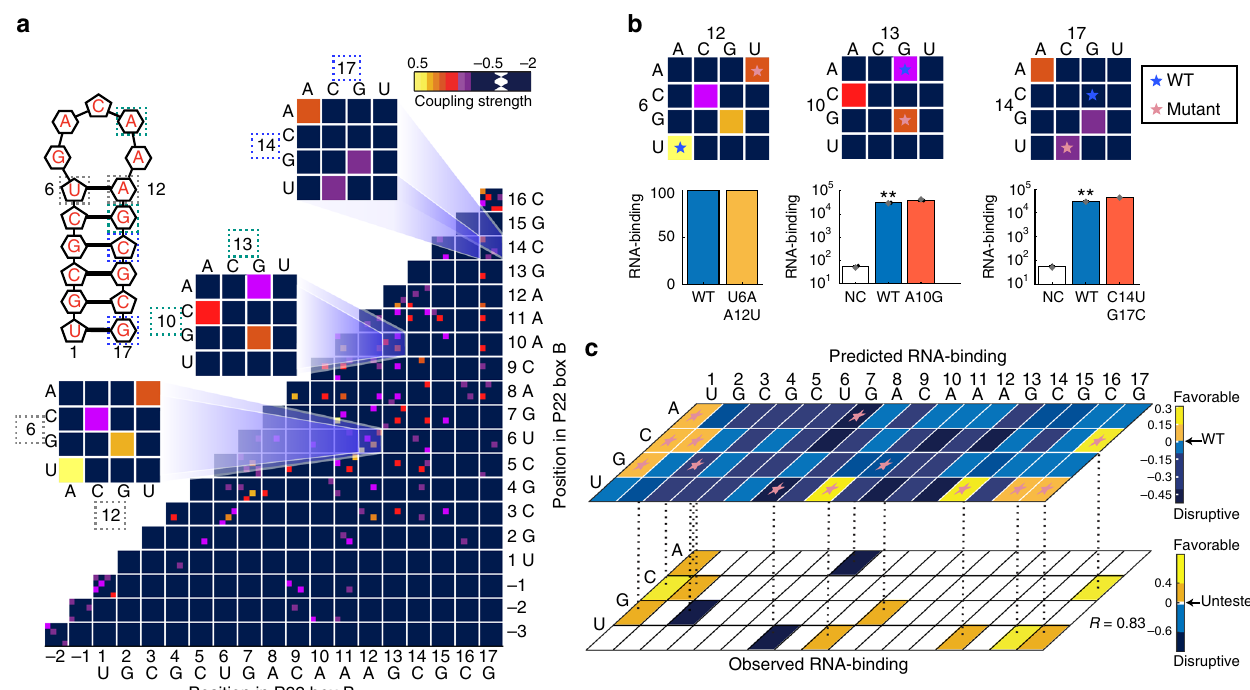
Fig. 3 The P22N DCA-scape elucidates recognition of the Box B left element. a The P22 N protein-binding recognition landscape. Interactions are shaded according to the inset color scale. Representative interactions are enlarged to indicate predicted mutational outcomes. b Experimental con fi rmation of alternative speci fi cities. The wild-type Box B left sequence is indicated with a blue star while mutants are labeled with pink stars. The U6A A12U mutation was previously described as an alternate binding mode and is predicted to result in a favorable interaction (6C – 12C is observed in the wild-type Box B right motif). The A10G single mutant and C14U, G17C double mutant were analyzed using the yeast-three hybrid assay (error bars represent 1 standard deviation, three biological replicates corresponding to separate cultures were conducted for each measurement, **represents p -value < 0.01 under one- tailed t -test). Both mutations predicted to be favorable retain binding. c A mutational landscape of the Box B left sequence. The upper panel illustrates the predicted binding speci fi city matrix for all possible single mutations. Red stars indicate substitutions that were analyzed experimentally. The lower panel provides the experimentally observed binding activities collected based on these predictions (see Supplementary Table 1). Boxes are colored by the relative change using the wild type sequence as a point of reference. The landscape accurately captures both disruptive and favorable changes in protein – RNA recognition between protein P22 and the structured RNAs (six biological replicates corresponding to separate cultures were conducted for each